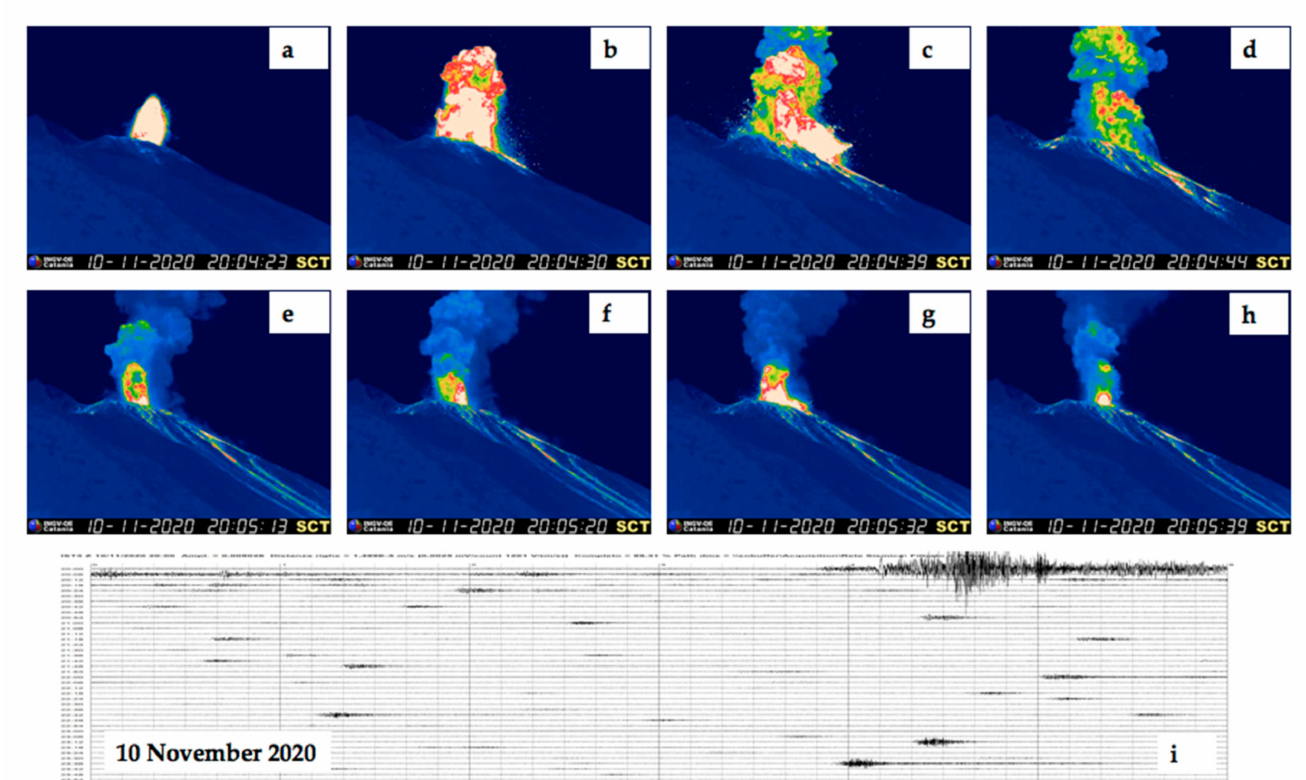
Figure 11. ( a – c ) Thermal images from the SCT camera recorded on 10 November 2020 at 20:04:23 ( a ), at 20:04:30 ( b ), at 20:04:39 ( c ), at 20:04:44 ( d ), at 20:05:13 ( e ), at 20:05:13 ( f ), at 20:05:32 ( g ) and at 20:05:39 ( h ), view from NE. Blue is cold, white is hot. ( i ) Seismic trace of the explosive episode, recorded by the IST3 station. See Figure 1 for station